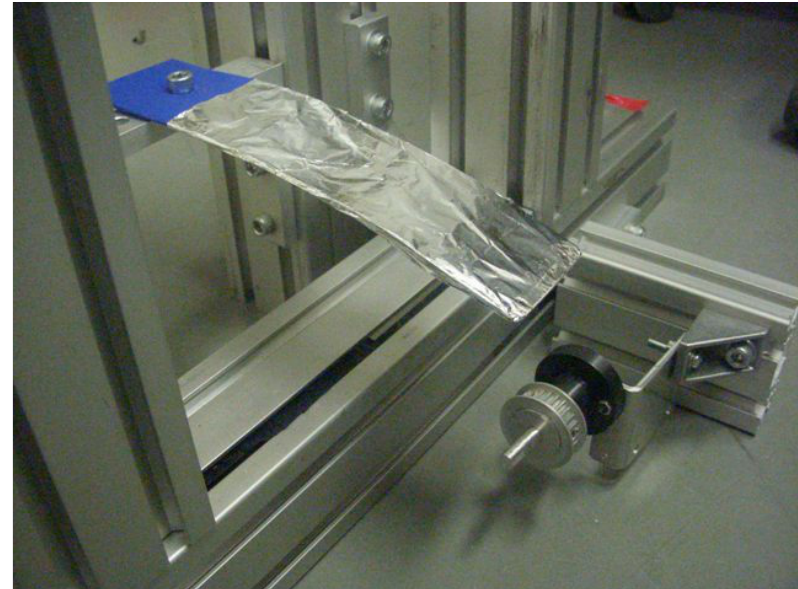
Figure 18. Testbed for variable